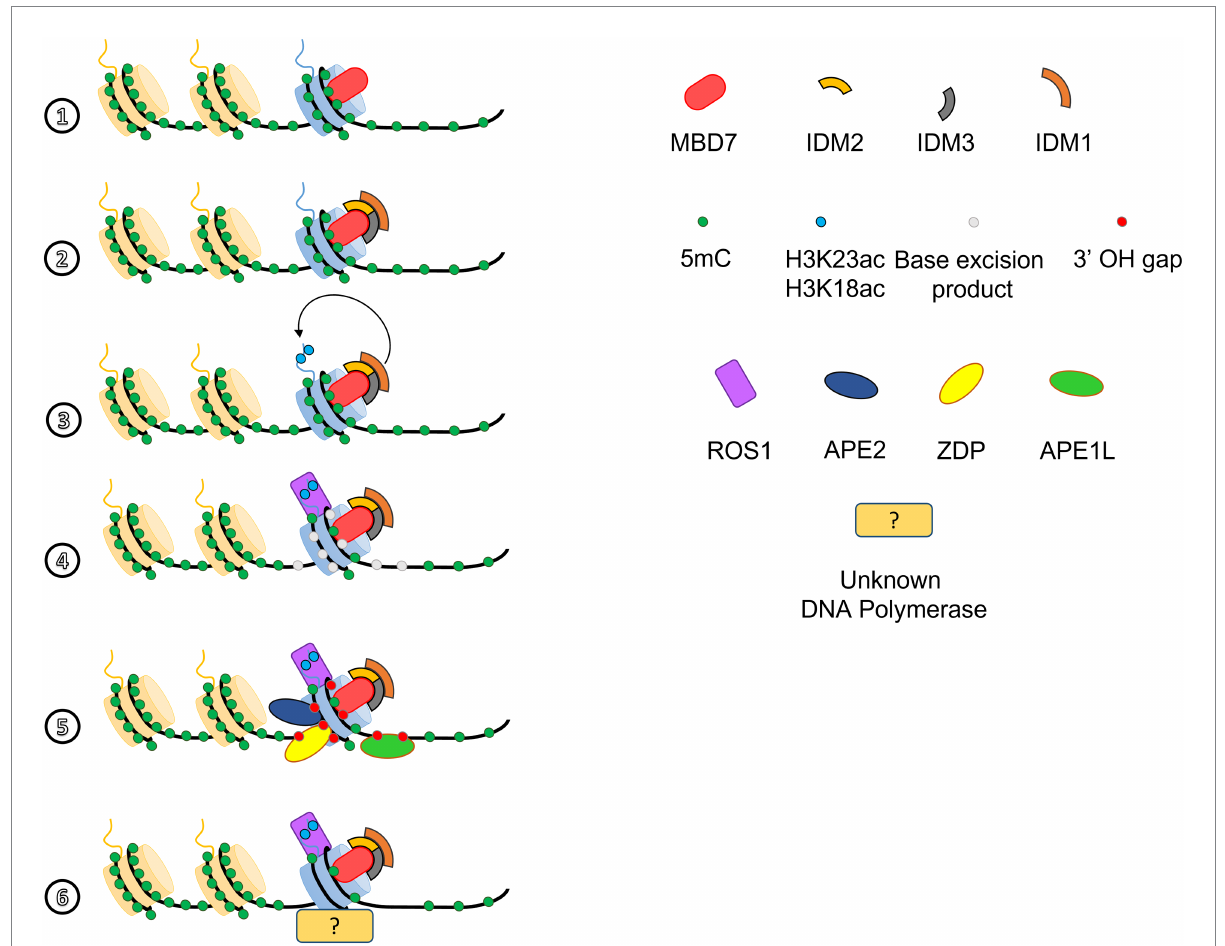
FIGURE 1 Methyl-CpG-Binding Domain 7 (MBD7), ROS1, and the base excision repair pathway act together to locally demethylate DNA. MBD7 binds highly methylated loci (1) and, through binding of IDM2 and IDM3, targets the histone methyl transferase IDM1 to mCG-dense regions (2). IDM1 ensures in situ deposition of H3K18ac and H3K23ac marks (3), which allows ROS1 to be addressed to hypermethylated regions (4; Lang et al., 2015). After removal of 5mC by ROS1 (4), the excision product can be processed by APE1L, APE2, and ZDP to create a 5’P-3’OH gap (5), which is then filled by a yet unknown DNA polymerase and sealed by DNA ligase I (6; Li et al., 2015c,d,